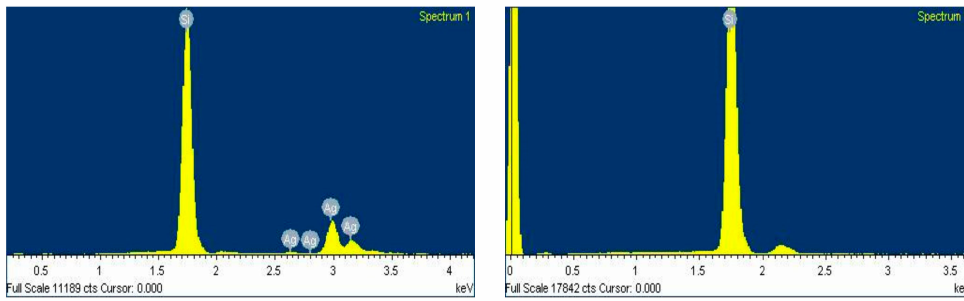
Figure 11. Energy dispersive X-ray spectroscopy (EDS) measurement results before and after remov- ing Ag